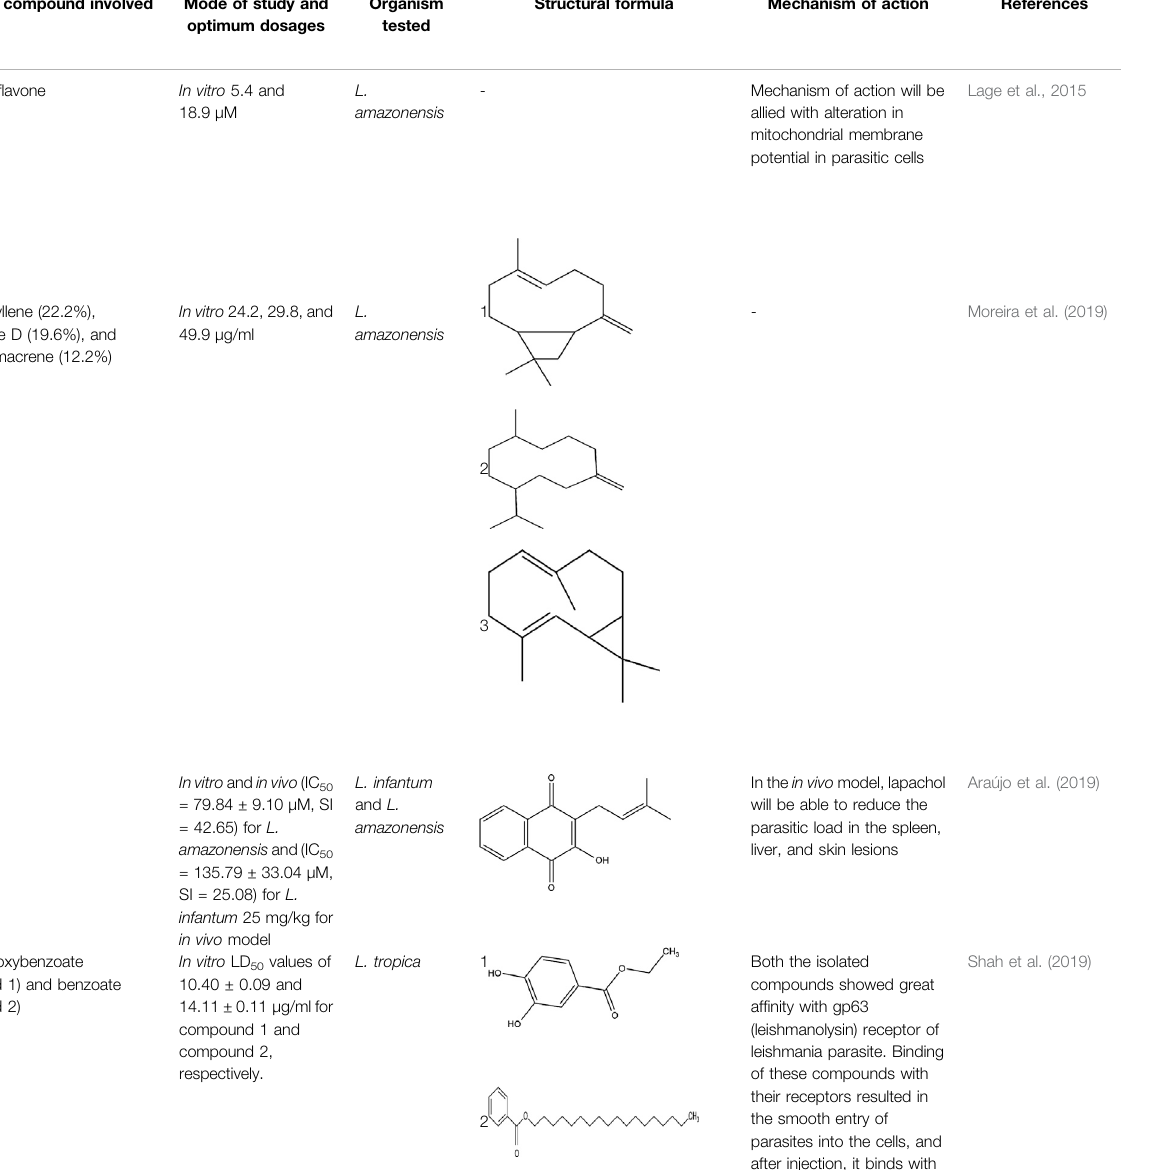
TABLE 1 | ( Continued ) Role of plant-based natural products in the treatment of